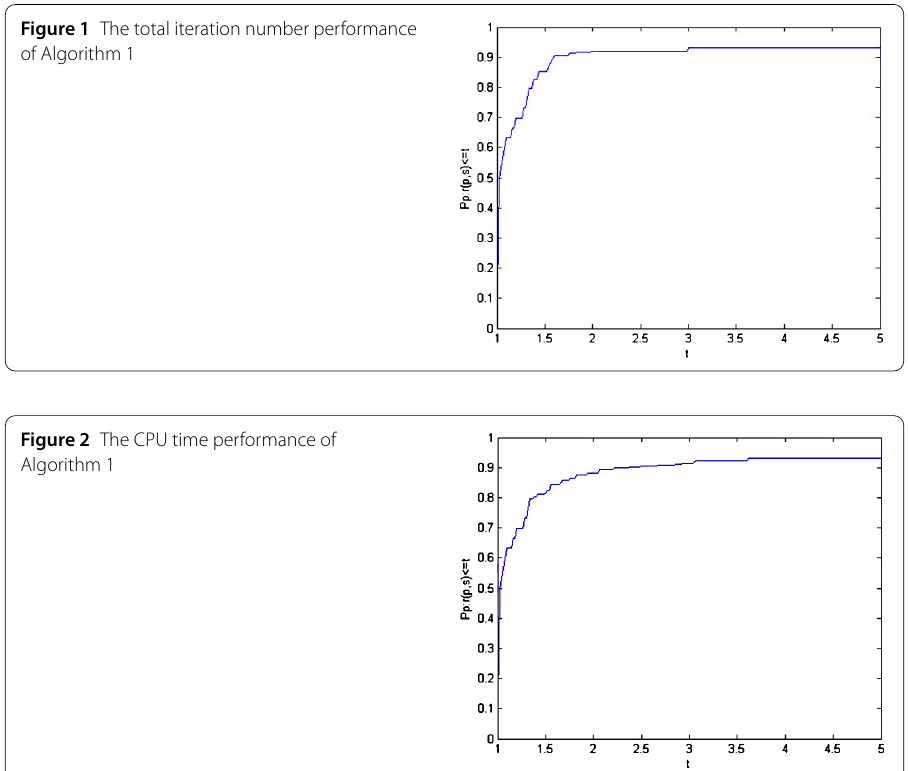
Figure 2 The CPU time performance of Algorithm